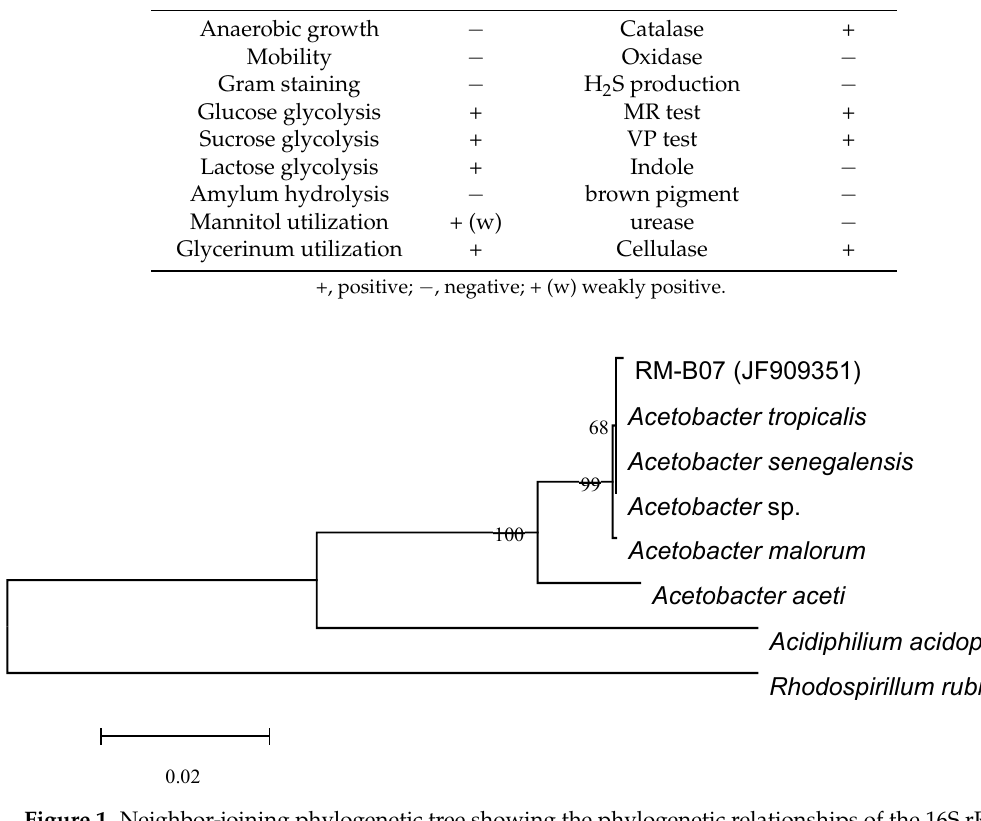
Figure 1. Neighbor-joining phylogenetic tree showing the phylogenetic relationships of the 16S rRNA gene sequences of strain RM-B07 with those related sequences available in GenBank database. Scale 0.02 represents the distance of evolution. Bootstrap replications of 1000 were used. Table 1. Physiological characteristics of strain RM-B07.